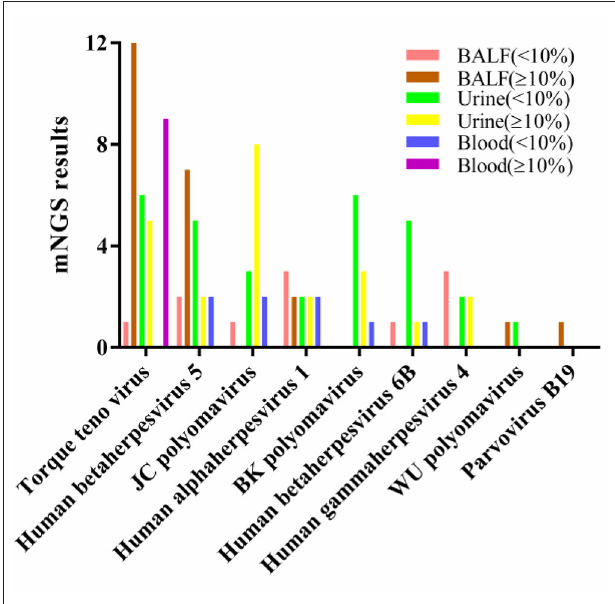
FIGURE 2 | Relative abundance of viral nucleic acids in three types of samples. BALF, bronchoalveolar lavage